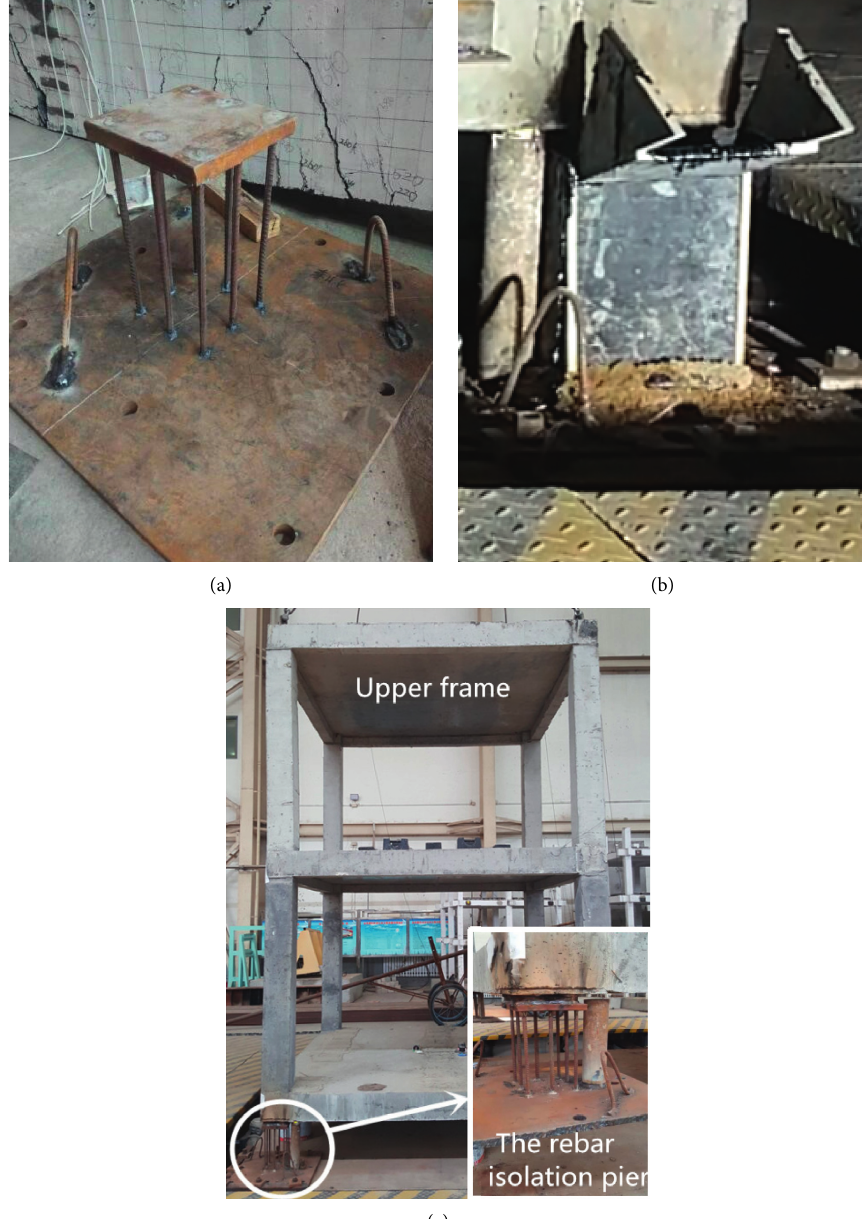
Figure 5: Real object of the rebar isolation pier: (a) rebar isolation pier without asphalt ointment, (b) rebar isolation pier with asphalt ointment, and (c) installed experimental